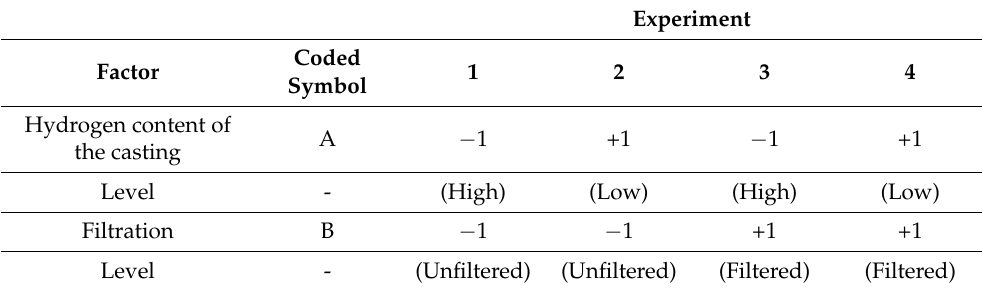
Table 1. Experimental